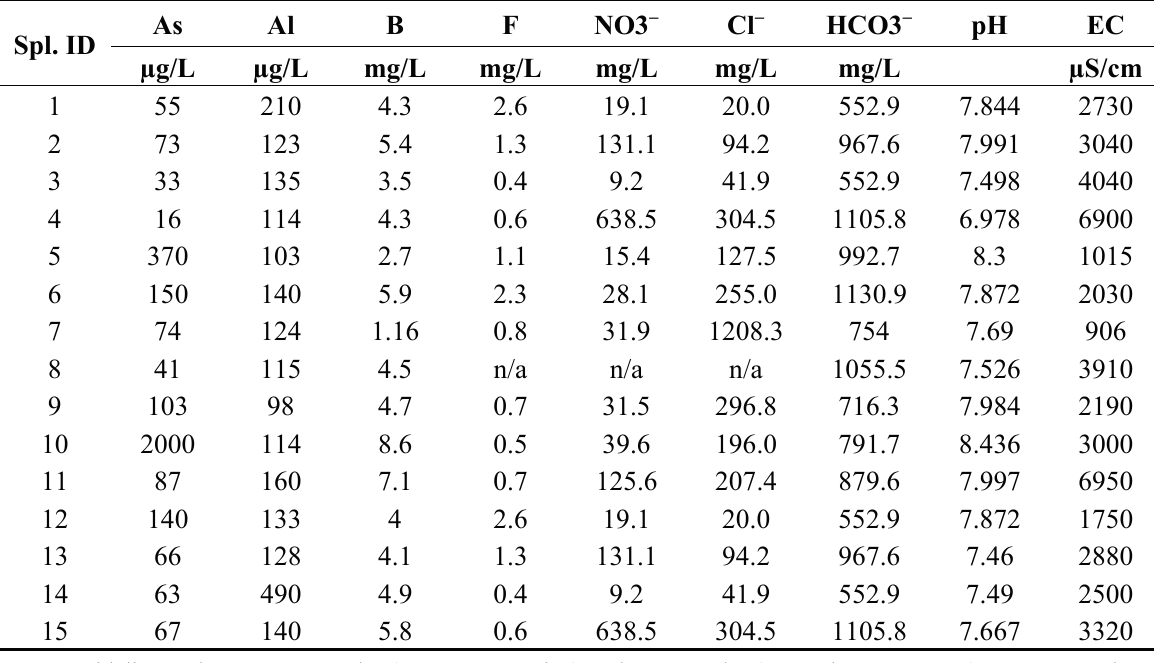
Table 2. Drinking water quality parameter * of 15 ground water samples taken near Rafaela, Santa Fe Province, Argentina (bold numbers indicate a concentration value above the guideline value *